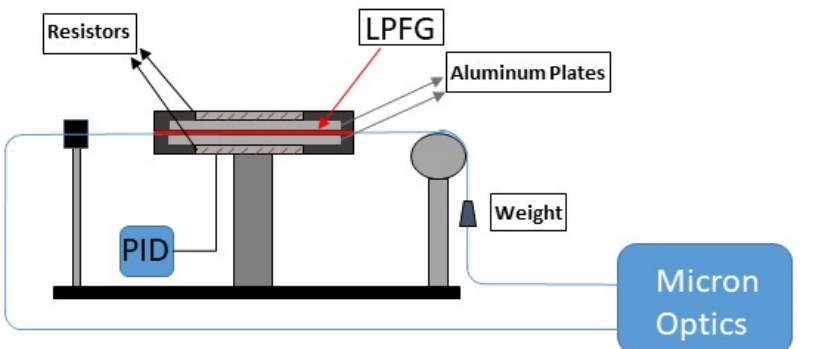
Figure 3. Experimental setup. Proportional Integral Derivative (PID) controller was used for temper- ature control.